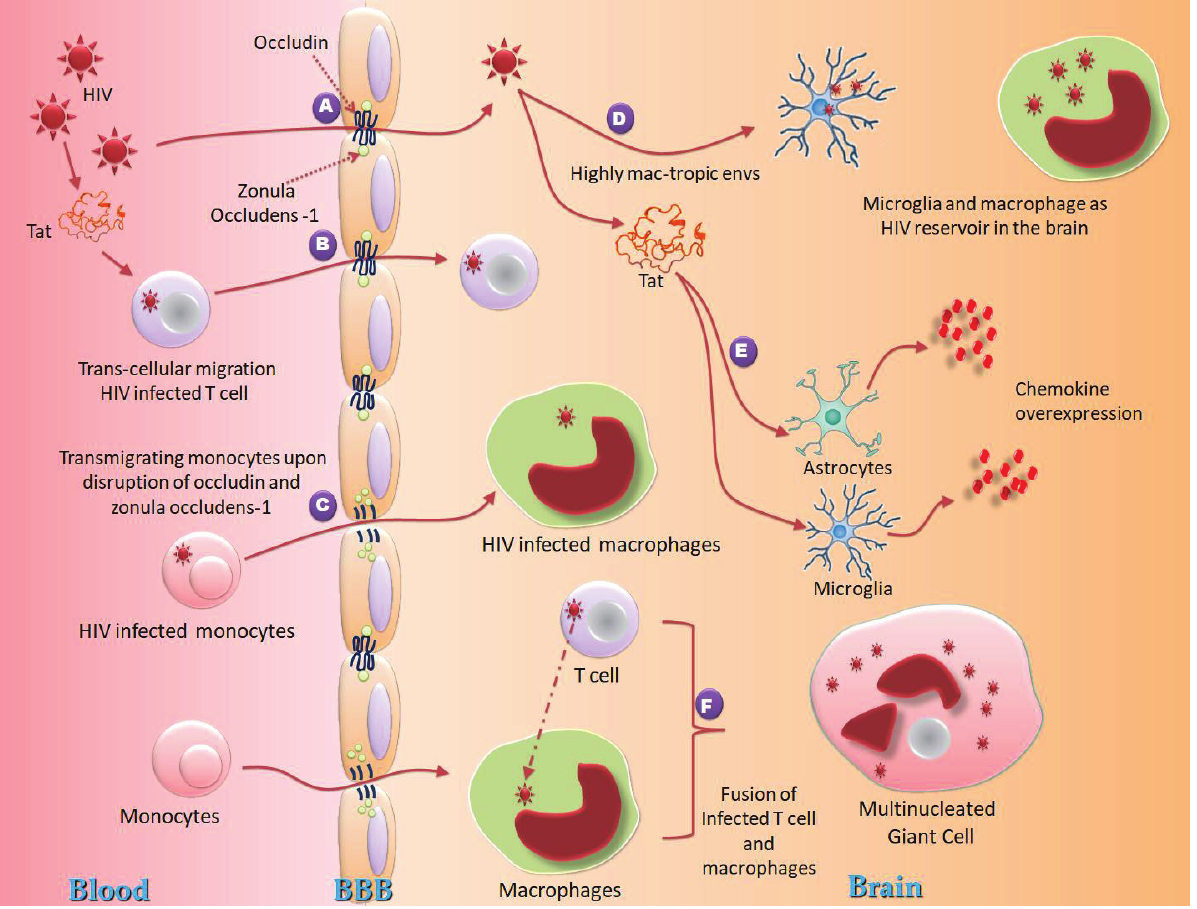
Figure 1: Mechanism of HIV Neuropathogenesis. (A) Cell independent transmigration of HIV across the BBB, (B) HIV-1 Tat protein functions as a growth factor resulting in the trans-cellular migration of HIV infected cells into the brain, (C) Disruption of endothelial tight junction proteins, specifically occludin and zonula occludens-1, results in transmigration of monocytes/macrophages into the brain, (D) The presence of highly mac-tropic HIV-1 R5 envs in the brain tissue is responsible for the adaption for replication in microglia and macrophages, which in turn forms the principal HIV reservoir. (E) Viral Tat protein induces the over-expression of chemokines by astrocytes and microglia, which are responsible for the leukocyte entry to CNS, (F) Interaction between infected T cells and macrophages leading to cell fusion and the generation of highly virus productive multinucleated giant cells astrocytosis. Increased proliferation of progenitor cells in the subgranular zone and hippocampal dentate granule cell layer have been observed in HIVE brain autopsy sample [14].In HIVE patients, Tat mRNA and protein has been detected in the brain tissue extract [16]. Tat has been shown to cross the BBB via a nonsaturable mechanism with a unidirectional influx rate of about 0.490 microl/gram/ min, where 0.126% of an intravenous dose of Tat enters each gram of the brain. The most Tat-permeable regions of the brain are the hypothalamus, occipital cortex, and hippocampus [17]. Tat has been detected in 42% of CSF samples by ELISA from HIV-infected individuals [18].